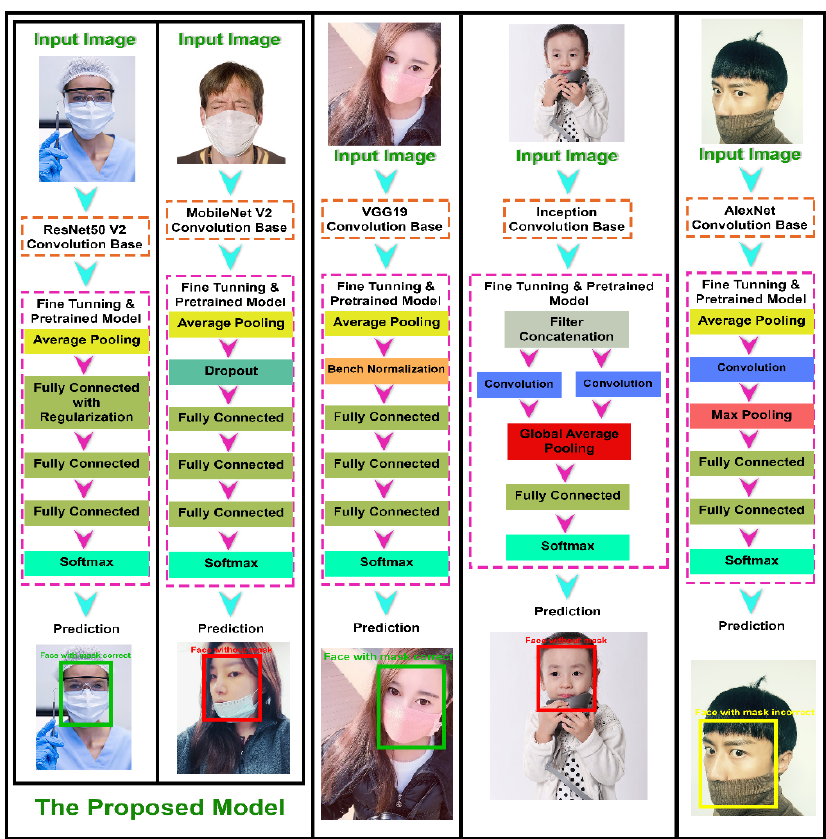
Figure 4. Transfer learning using MobileNetV2, VGG19, ResNet50V2, AlexNet, and InceptionV3.